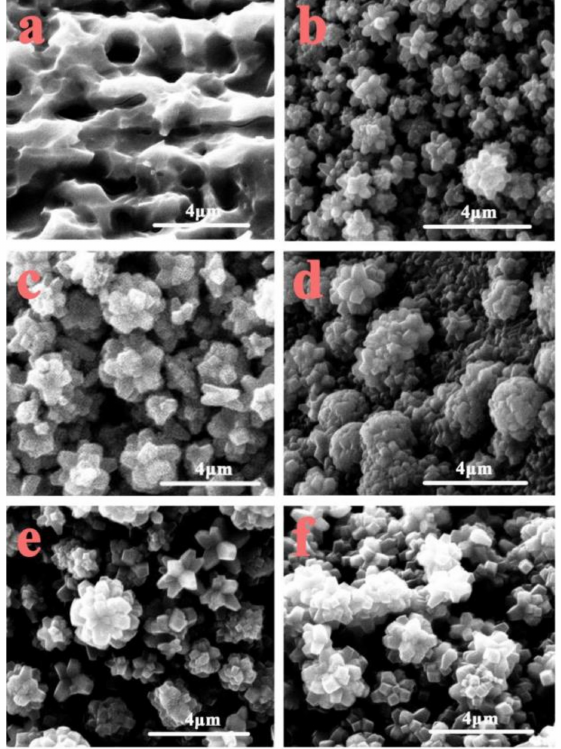
Figure 1. Scanning electron microscope imaging of the pure unetched Ti mesh ( a ) and etched meshes ( b – f ) after different etching hydrothermal times of 4, 6, 7, 8, and 10 h, respectively.